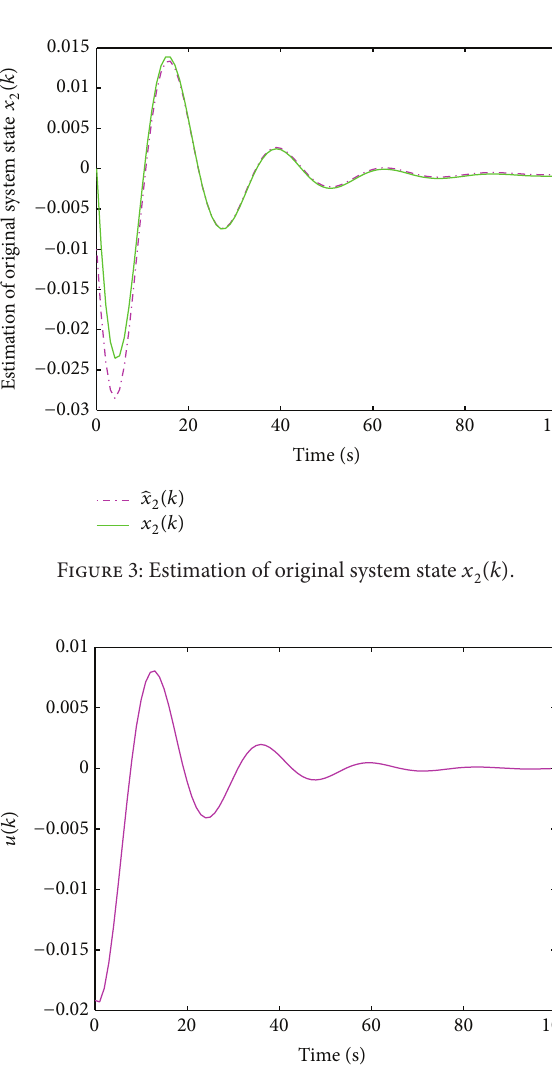
Figure 4: The control input signal 𝑢(𝑘)